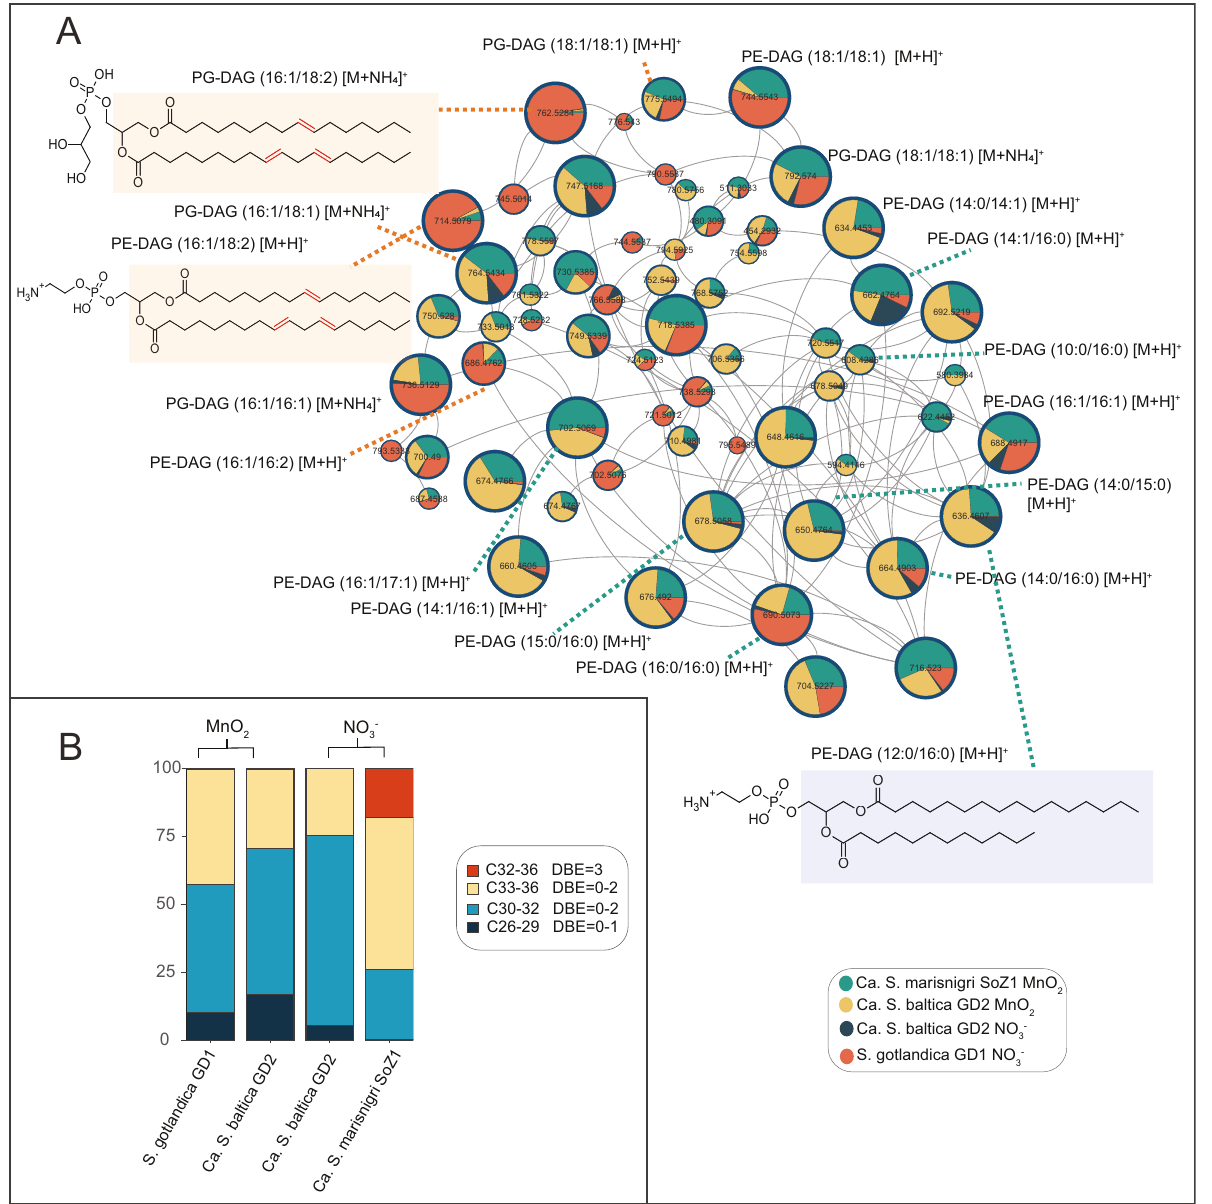
Fig. 2 A Molecular subnetwork of PE-DAGs and PG-DAGs. Pie charts shown in the subnetwork are the same as nodes shown in Fig. 1, representing fractional abundance of different individual lipids. The size of the pie charts represents the summed intensity of the ion component in all the species grown with various electron acceptors. Colors of the pie chart represent the fractional abundance of this ion component among all the Sulfurimonas species and different treatment. Numbers in the pie charts are the precursor mass of the lipids. Double bonds of the lipid structure are localized tentatively to show their numbers rather than their exact position.; B PE-DAG and PG-DAG lipids and their fractional abundance (of total PE-DAGs and PG-DAGs in %) shown in subnetwork of Fig. 2A. The numbers in the labels stand for the total number of carbon atoms of the two acyl chains (C26 – 36) and their summed double bonds (DBE = 0 – baltica GD2, grown with NO (cid:1) from 5 to 11 and in their acyl carbon atoms from 34 to 36, , produced much less C 5 PDA-DAGs 3 leading to their tentative assignment as phosphatidyldiazoalkyl- (27% of total PDA-DAGs), and mostly C 7 PDA-DAGs, (73%) diacylglycerols (hereafter, PDA-DAGs). The structural identi fi ca- tion here is tentative, further structural elucidation methods (e.g., nuclear magnetic resonance [NMR] spectroscopy) would be required to con fi rm the proposed structures and elucidate the position of the various functional groups. The PDA-DAGs with a short C5 alkyl chain in the headgroup were dominant in the two cultures that used MnO 2 as the electron acceptor: Ca. S. marisnigri (90% of total PDA-DAGs) and Ca. S. baltica (74% of total PDA-DAGs) (Fig. 3B). In contrast, Ca. S.